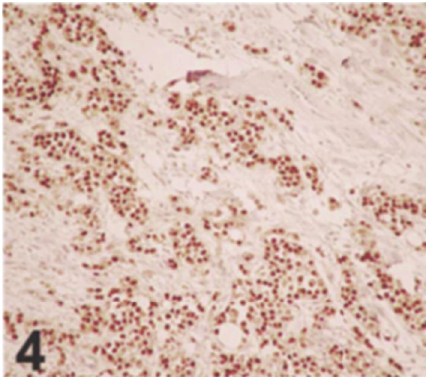
Figure 8: The neoplastic cells are strongly immunoreactive for p63